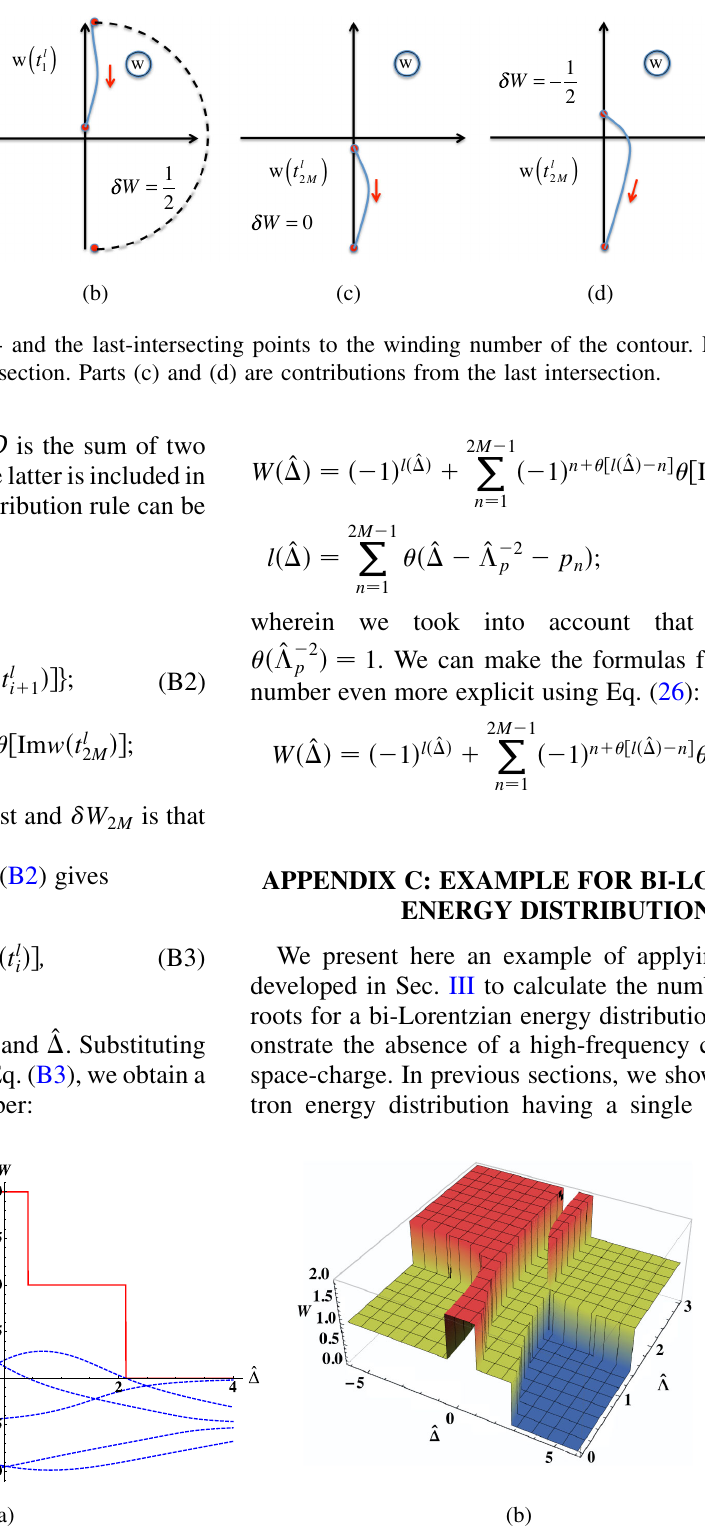
FIG. 11. The number of growing modes for an electron beam with bi-Lorentzian energy distribution as described in Eq. (C1). (a) The abscissa represents the normalized detuning and the ordinate is either the winding number (red solid curve) or the normalized growth rate (blue dashed curves). The winding number was calculated from Eq. (35) for (cid:9) ¼ growth rate obtained by solving Eq. (4) with the dispersion integral given by Eqs. (C5) and (C6). (b) The number of growing modes as a function of the space-charge parameter and the normalized detuning as calculated from Eq. (35) for (cid:9) ¼